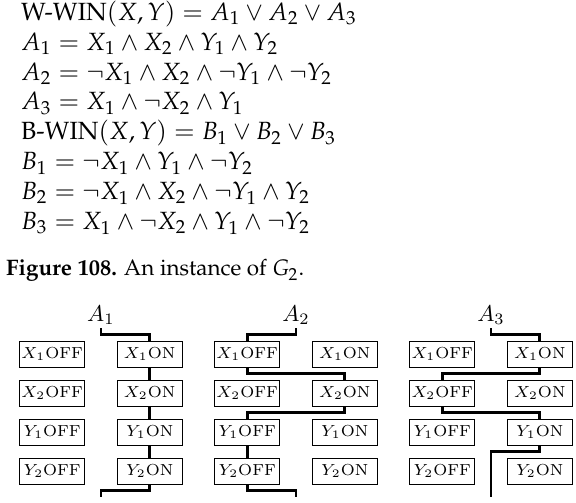
Figure 109. W-winning